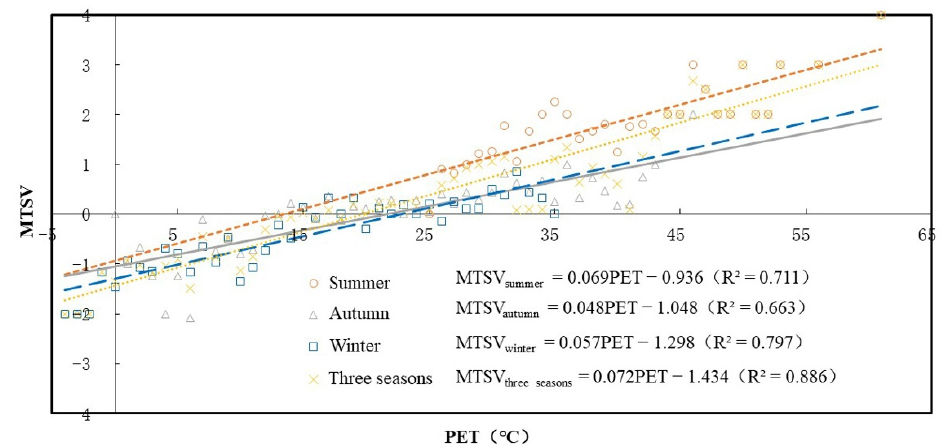
Figure 5. The relationships between the MTSV and PET in the summer, autumn, winter, and three seasons.